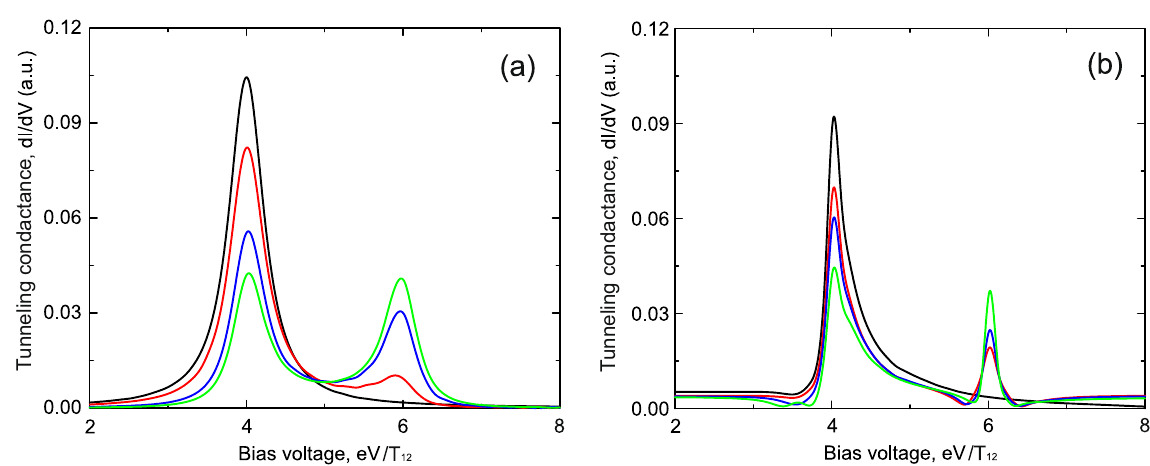
Figure 3. (Color online) Tunneling conductance as a function of applied bias voltage for the impurities configuration shown in Fig.2a. (a) Demonstrates results in the absence of Coulomb interaction; (b) shows calculation results in the presence of infinitely large Coulomb interaction. Black curves correspond to the tunneling rates t L 1 = 0.5 T 12 , t R 1 = 0.5 T 12 , t L 2 = 0.5 T 12 , t R 2 = 0.5 T 12 ; red curves correspond to the tunneling rates t L 1 = 0.8 T 12 , t R 1 = 0.8 T 12 , t L 2 = 0.5 T 12 , t R 2 = 0.5 T 12 ; blue curves correspond to the tunneling rates t L 1 = 1.2 T , t R 1 = 1.2 T 12 , t L 2 = 0.5 T 12 , t R 2 = 0.5 T 12 ; green curves correspond to the tunneling rates t L 1 = 1.5 T 12 , t R 1 = 1.5 T 12 , t L 2 = 0.5 T 12 , t R 2 = 0.5 T 12 . Parameters ε 1 = ε 2 = 5.0 T 12 , T 12 = 1 are the same for all figures.